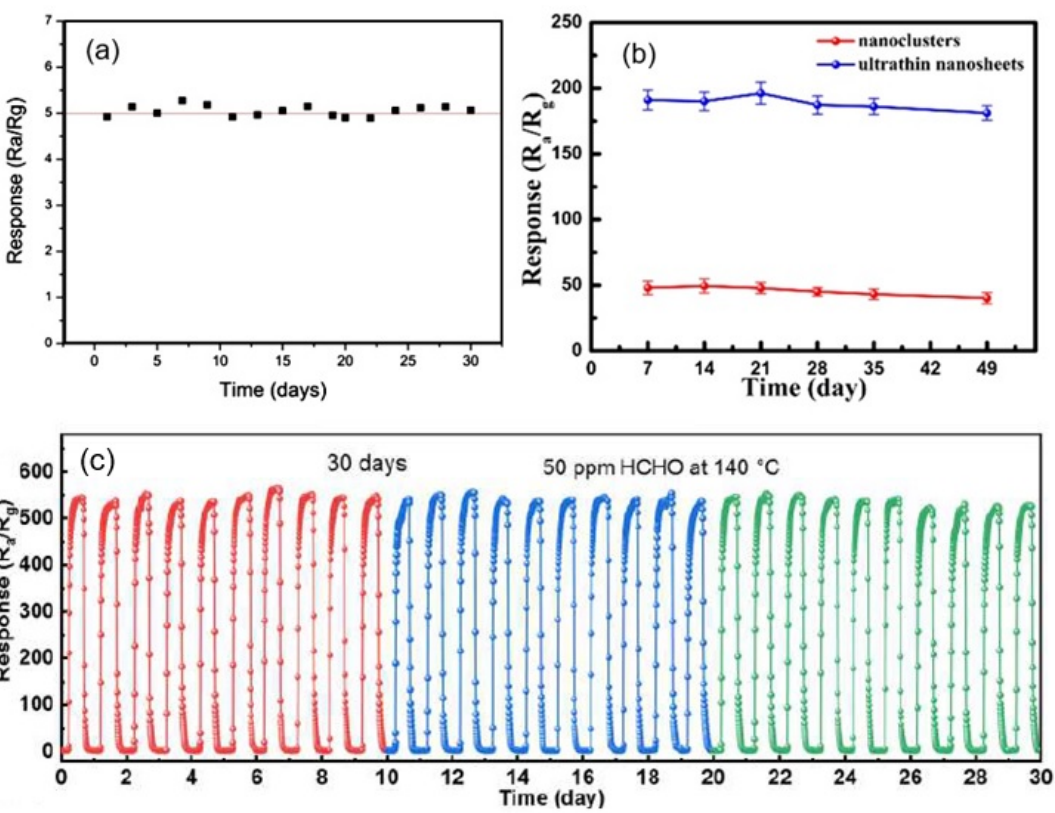
Figure 15. ( a ) Long-term stability of the porous CuO nanosheet-based gas sensor exposed to 200 ppb H 2 S gas at room temperature. Reprinted with permission from [40]. Copyright 2016: ACS; ( b ) Long-term stability of the response of ZnO-based sensor toward acetylacetone at 340 ◦ C. Reprinted with permission from [100]. Copyright 2019: ACS. ( c ) Durability of SnO 2